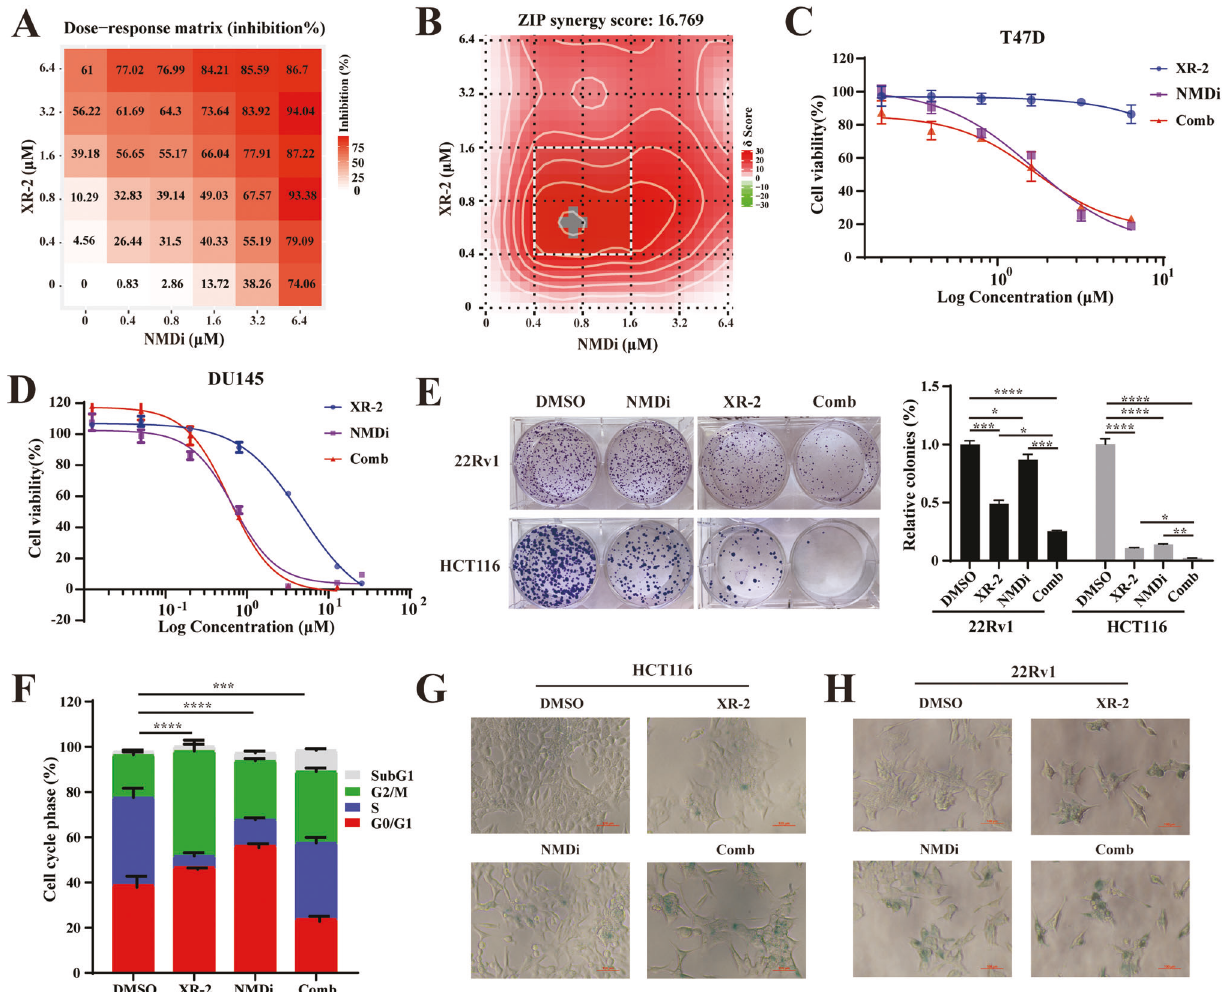
Fig. 3 Combination of XR-2 with NMDi exhibited synergistic effects on TP53 wild-type solid cancer cell lines. A Dose – response matrix of 22Rv1 cells was treated with different concentrations of NMDi and XR-2 for 72 h. B Zip model to evaluate the synergistic effects using data from the dose – response matrix. C , D Cell viability assay detected by CCK-8 kit of two TP53 -mutated cell lines ( C : T47D; D : DU145) treated with the indicated concentration of XR-2 and NMDi alone or in combination for 72 h. E Images and quantitative results of the colony-forming assay of 22Rv1 and HCT116 cells treated with NMDi or XR-2 alone or in combination. HCT116 cells were treated with 3.2 µM XR-2 and 3.2 µM NMDi alone or in combination, and 1.6 µM of these two agents were incubated with 22Rv1 cells. (Data are mean ± standard deviation, and p -values were calculated by the ungrouped t -test. * p ≤ 0.05, ** p ≤ 0.01, *** p ≤ 0.001, **** p ≤ 0.0001; ns not signi fi cant. N = 3) F Analysis of the proportion of cells in each cell-cycle stage by propidium iodide staining in 22Rv1 cells treated with 3.2 µM XR-2 and 3.2 µM NMDi alone or in combination for 24 h. Statistical analysis was conducted using a chi-square test, and DMSO-treated cells were used as control. (Data are mean ± standard deviation, and p -values were calculated using ANOVA with Tukey HSD post hoc test. * p ≤ 0.05, ** p ≤ 0.01, *** p ≤